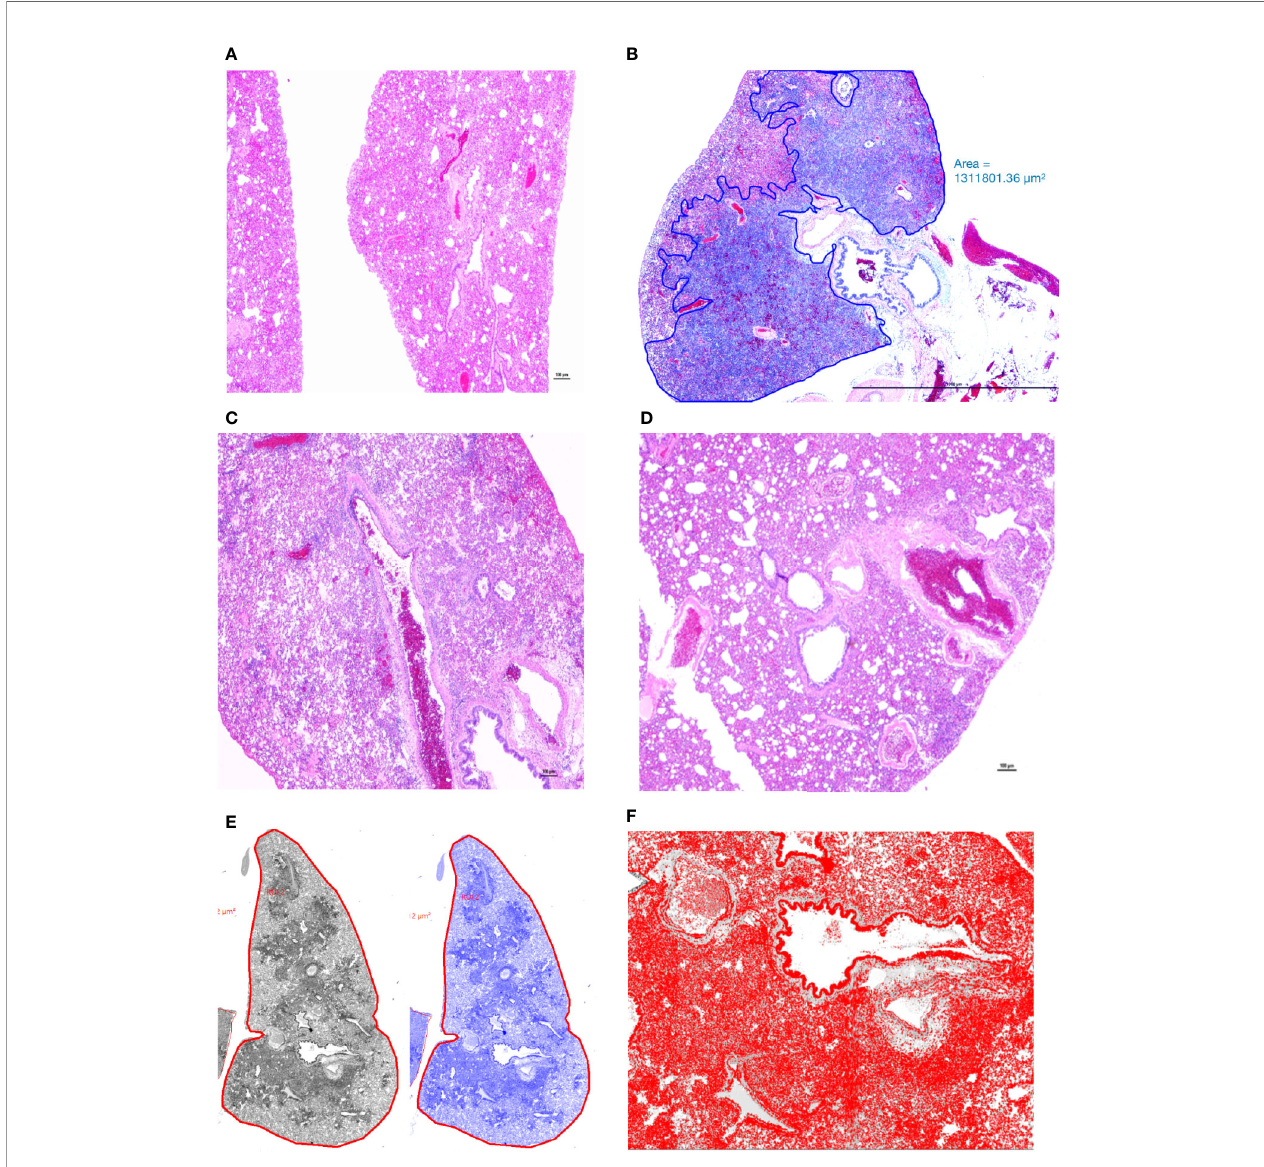
FIGURE 3 | Manual annotation and comparison of histological scores of bronchointerstitial pneumonia in control and treated hamsters. (A) Lungs from an uninfected hamster were visualized and scored for lack of signi fi cant hypercellularity. (B) Affected parenchyma of infected hamsters (Untreated) characterized by intense hypercellularity is manually annotated (blue) excluding unaffected lung parenchyma, main stem bronchi and hilar adipose tissue. (C) Lung section from a control antibody treated hamster (Ab Control) is showing marked reduction in total cellularity or in fl ammation. (D) Lung section from a low-dose AvGn-B antibody- treated hamster (AvGn-B Low) showing very signi fi cant reduction of in fl ammation reducing the total area of affected pulmonary parenchyma. (E) After manual annotation depicted in (B) and based on the generated montage including training set and threshold, the automated classi fi er to discriminate lesional from non- lesional parenchyma was generated in grey and then in blue. (F) After manual annotation of affected lungs, all of the de fi ned classes in preset ROI, i.e., in fl ammatory foci characterized by in fi ltration of in fl ammatory cells into alveolar spaces were identi fi ed to generate total number of nuclei (hematoxylin and DAPI-stained nuclei) that were accurately